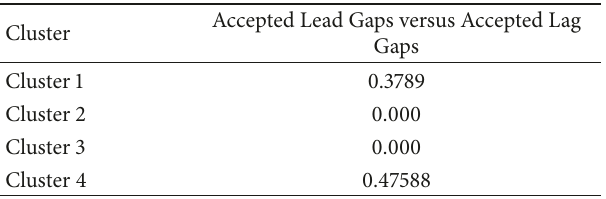
Table 6: Mann–Whitney 𝑈 test results between accepted lead gaps and lag